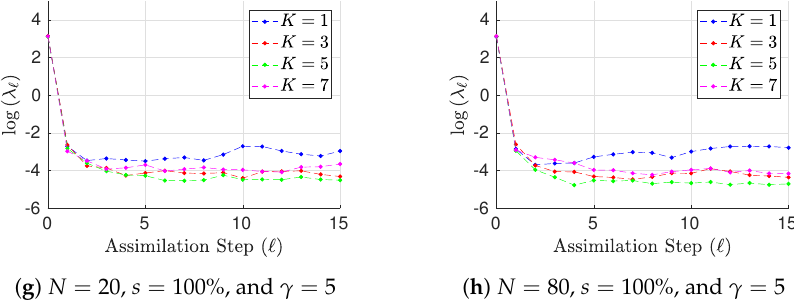
Figure 2. Experimental results with the Lorenz-96 model (29). The time evolution of mean analysis errors and their standard deviation across the 10 different experimental configurations are reported for γ ∈ { 1, 3, 5 } , and δ t = 50. Table 2. Experimental results with the Lorenz-96 model. Mean of RMSE values are reported across the 10 different experimental configurations for different configuration of parameters δ t , s , K , and γ . The number of ensemble members equals N =